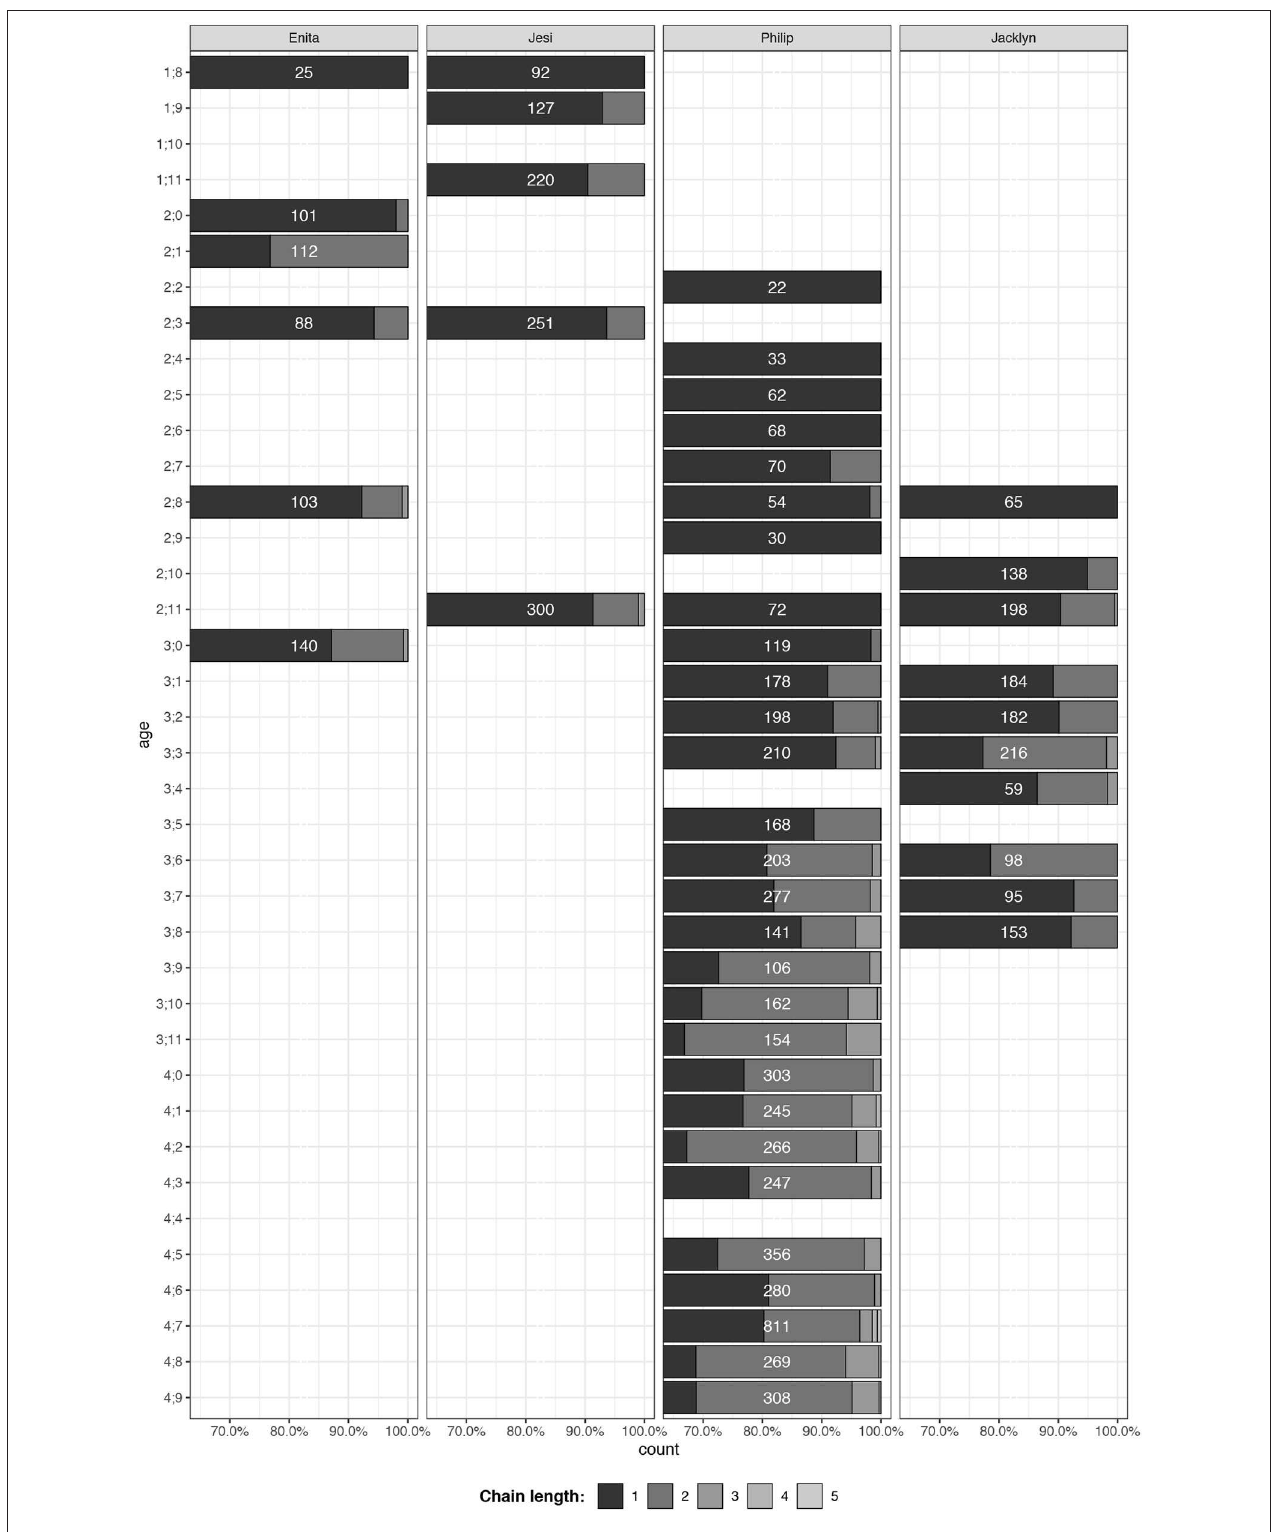
FIGURE 1 | Lengths of clause chains in longitudinal samples from four Ku Waru children.